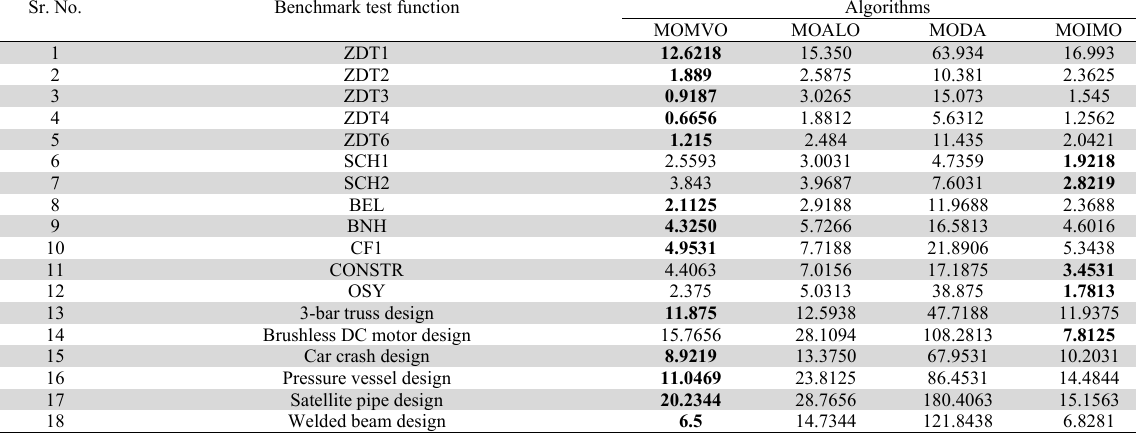
Comparison of algorithms in terms of computational time Sr.